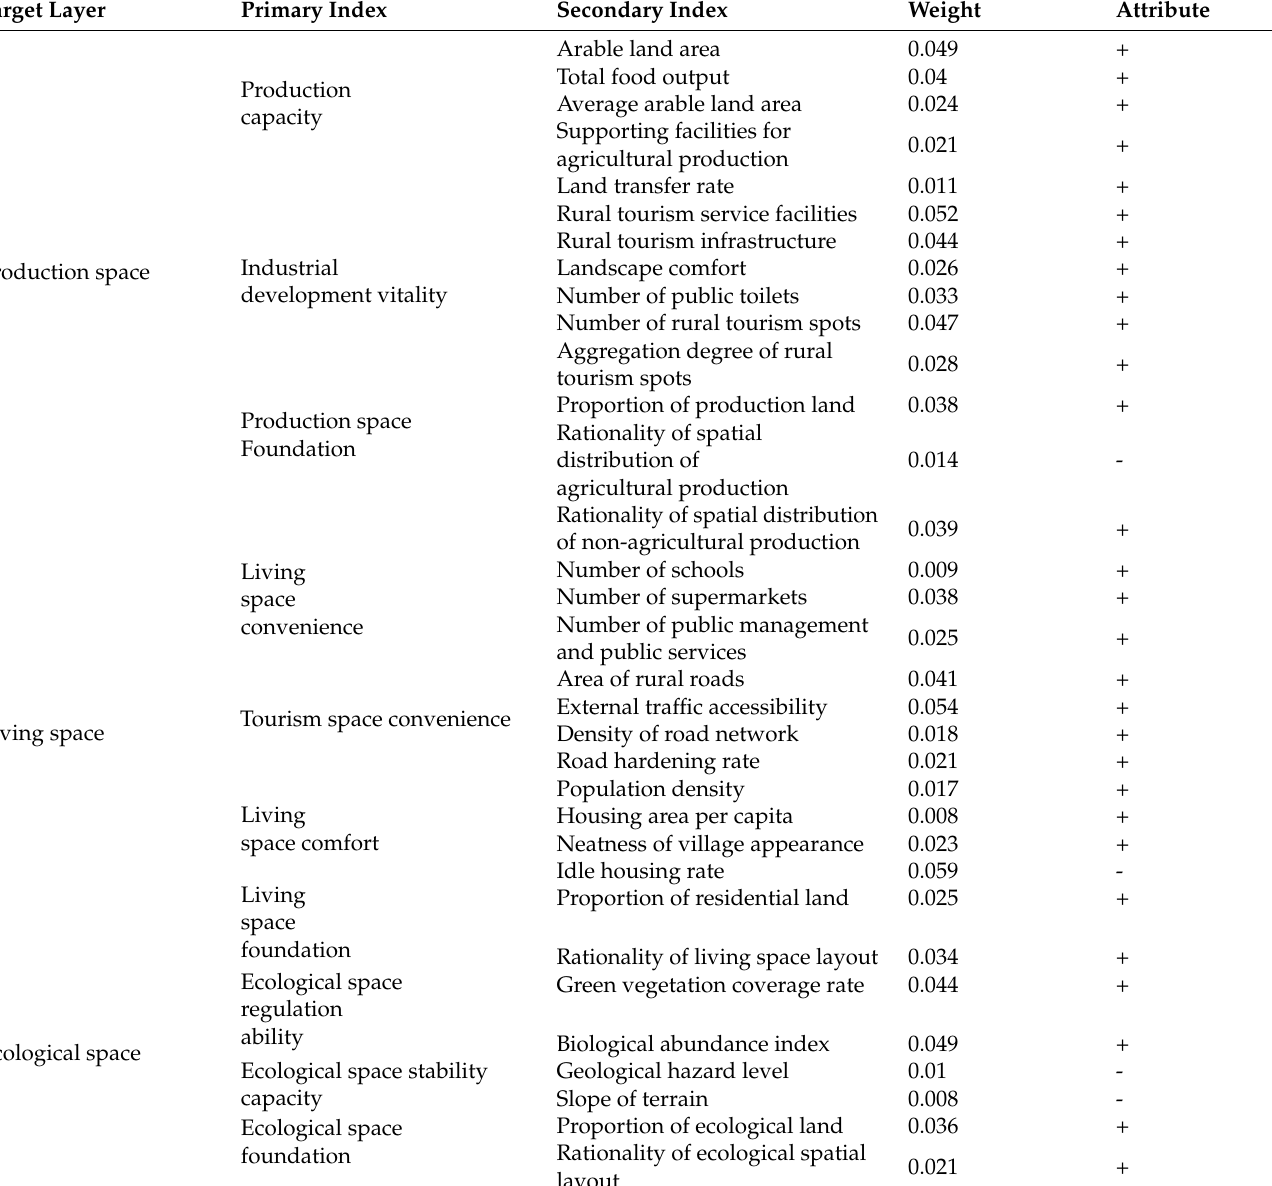
Table 2. Evaluation index system of rural space development